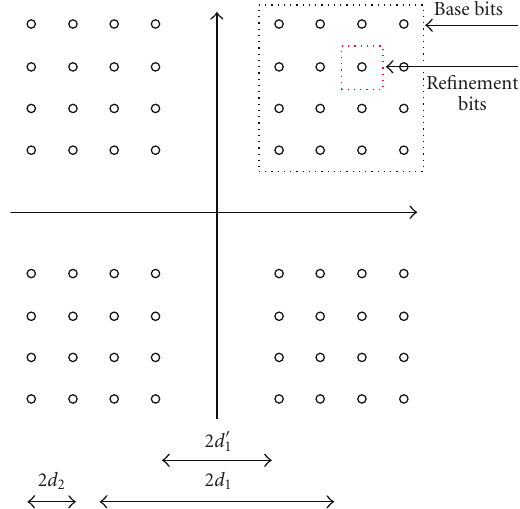
Figure 15: The 4 / 64-QAM hierarchical constellation modulated by two sequences of data bits.